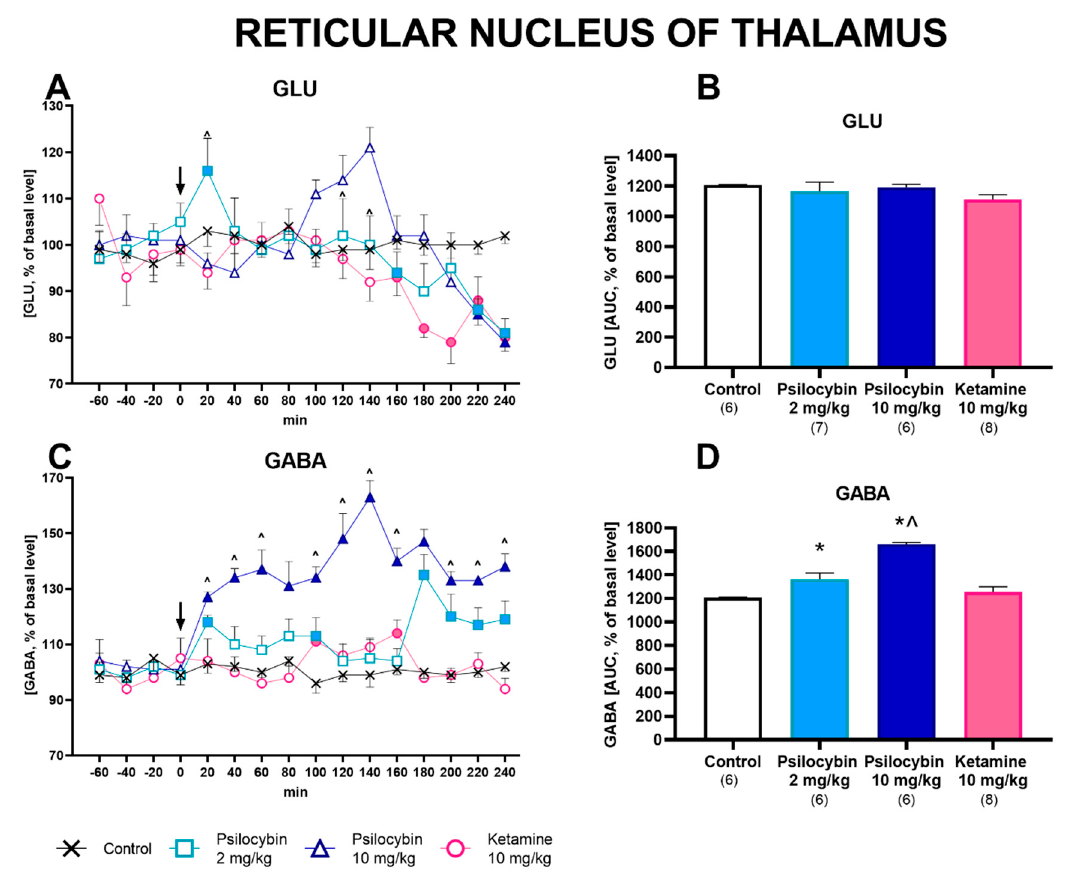
Figure 2. The time ‐ course ( A , C ) and total ( B , D ) effect of psilocybin (2 and 10 mg/kg) and ketamine (10 mg/kg) on the glutamate (GLU) and γ -aminobutyric acid (GABA) extracellular levels in the rat reticular nucleus of the thalamus. The total effect is calculated as an area under the concentration ‐ time curve (AUC) and expressed as a percentage of the basal level. Values are the mean ± SEM (n is given under the name of the group). The drug injection is indicated with an arrow. Filled symbols or * show statistical differences ( p < 0.03–0.001) between control and drug treatment groups; ^ p < 0.005–0.001 show differences between psilocybin 2 and 10 mg/kg groups as estimated by repeated measures ANOVA (time ‐ course) or one ‐ way ANOVA (total effect) followed by Tukey’s post hoc test.